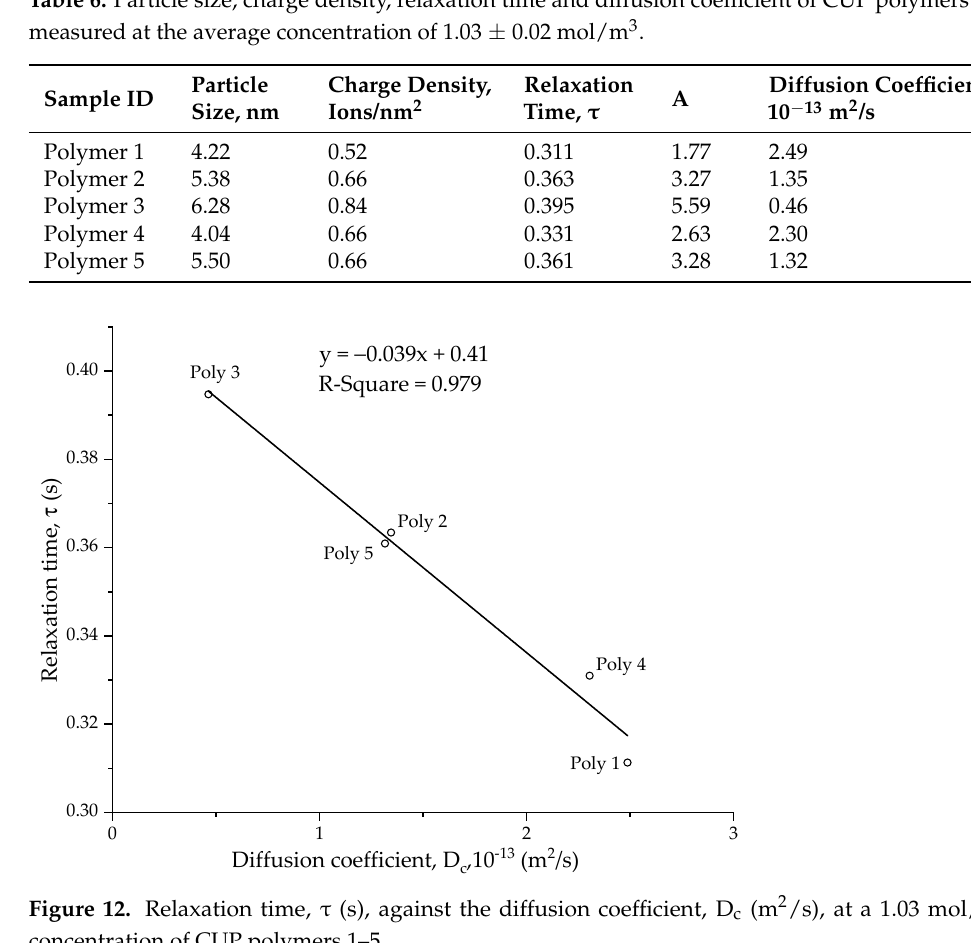
(m 2 /s), at a 1.03 mol/m 3 c